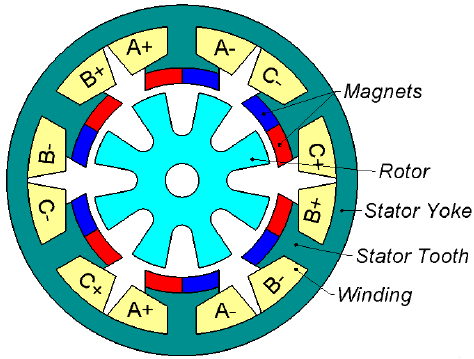
Figure 2. The three-phase FRM geometry according to [6].